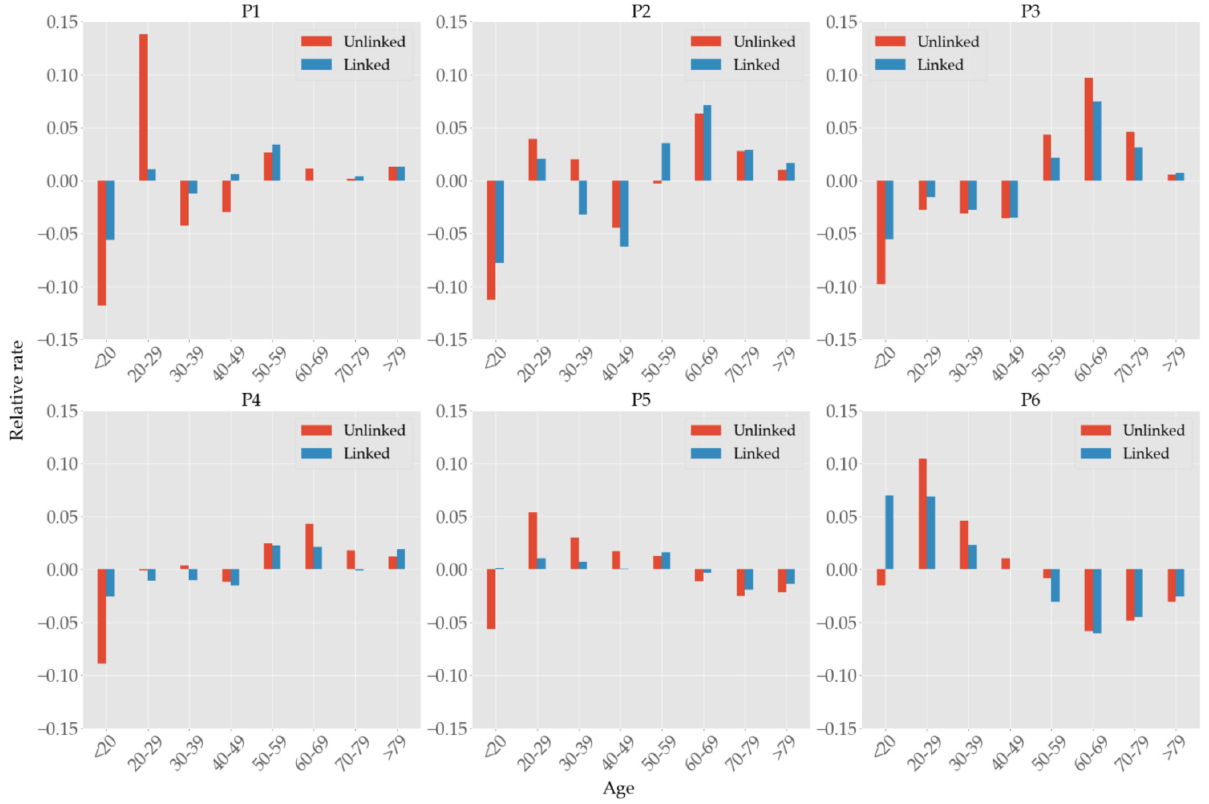
Figure 7. Shares of confirmed cases in each age group relative to its population size. For example, the unlinked cases of <20 in P1 is − 11.8%, meaning that the difference of its infection share and population share is −